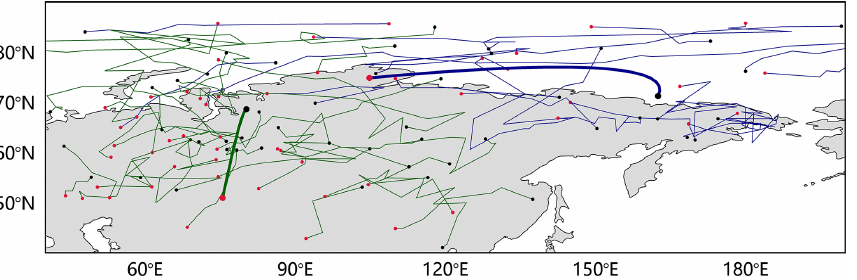
Figure 9. Poleward cyclones detected in the main entry channels (thin green line, 45–120 ◦ E and 40–90 ◦ N) and all cyclones that occurred in the regions intersecting with the route after the fluxes entering the Arctic (thin blue line, 45 ◦ E–15 ◦ W and 65–90 ◦ N) during spring (April to June) in 2020, and their typical trajectories (thick green and blue lines). Red dots represent the position of the genesis of cyclones and black dots represent the position of the lysis of